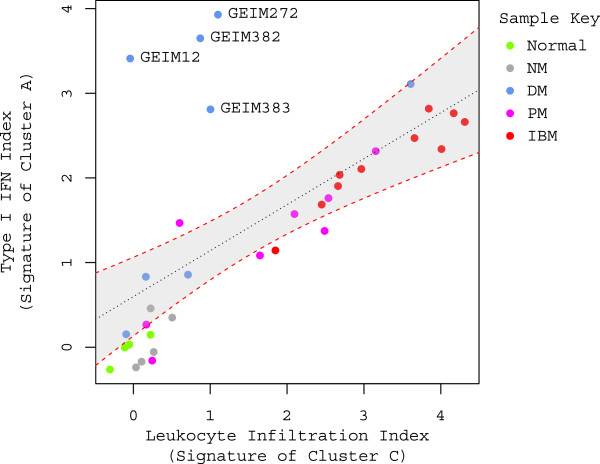
Correlation between type 1 IFN signature score and leukocyte infiltration index in myositis. A significant linear correlation is displayed in the scatter plot between type 1 IFN index and leukocyte infiltration index. Data points are colored by the sample type; color key is displayed in the upper right corner of the plot. The regression line (R2=0.41, p<0.001) is denoted by the black dotted line and 95% confidence interval is outlined by the red dotted line and gray shaded background. The subject identifiers of the four outliers are labeled. When excluding the four outliers, the R-squared value in the regression analysis escalates from 0.41 to 0.91.